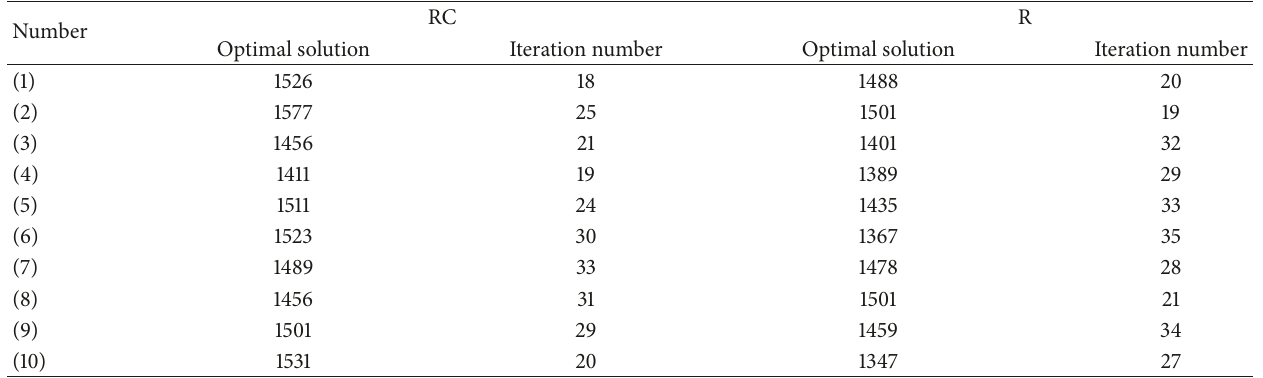
Table 2: Experimental results.